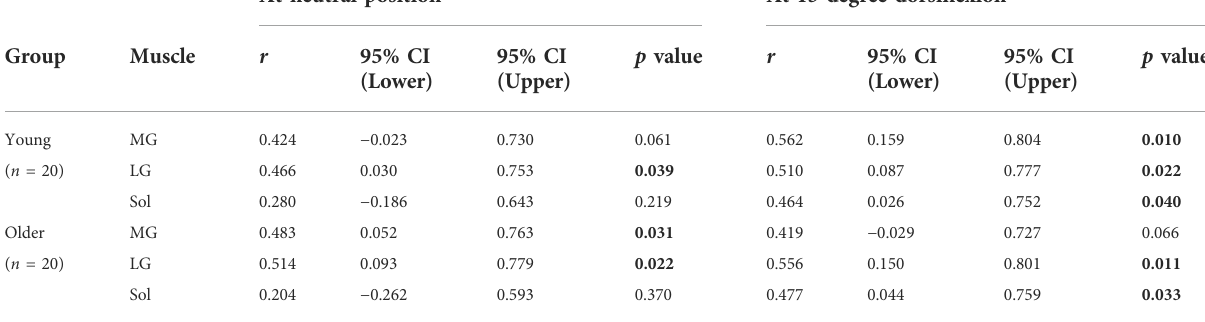
TABLE 4 Pearson correlation coef fi cients between the normalized ankle joint stiffness and muscle shear modulus of the triceps